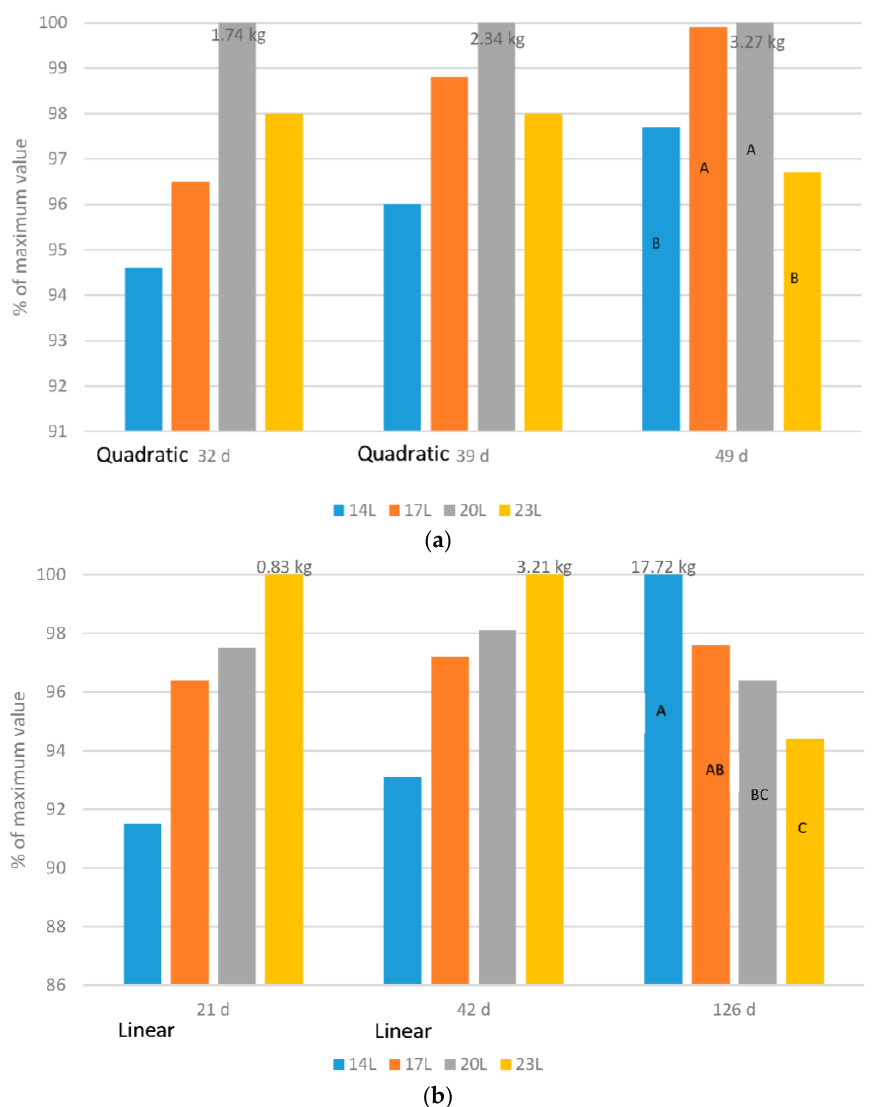
Figure 1. Impact of daylength on body weight. ( a ) Comparison of broiler body weight under four daylength photoperiods at three ages, with data expressed as a percentage of the maximum value within each age; ( b ) Comparison of turkey body weight under four daylength photoperiods at three ages, with data expressed as a percentage of the maximum value within each age.